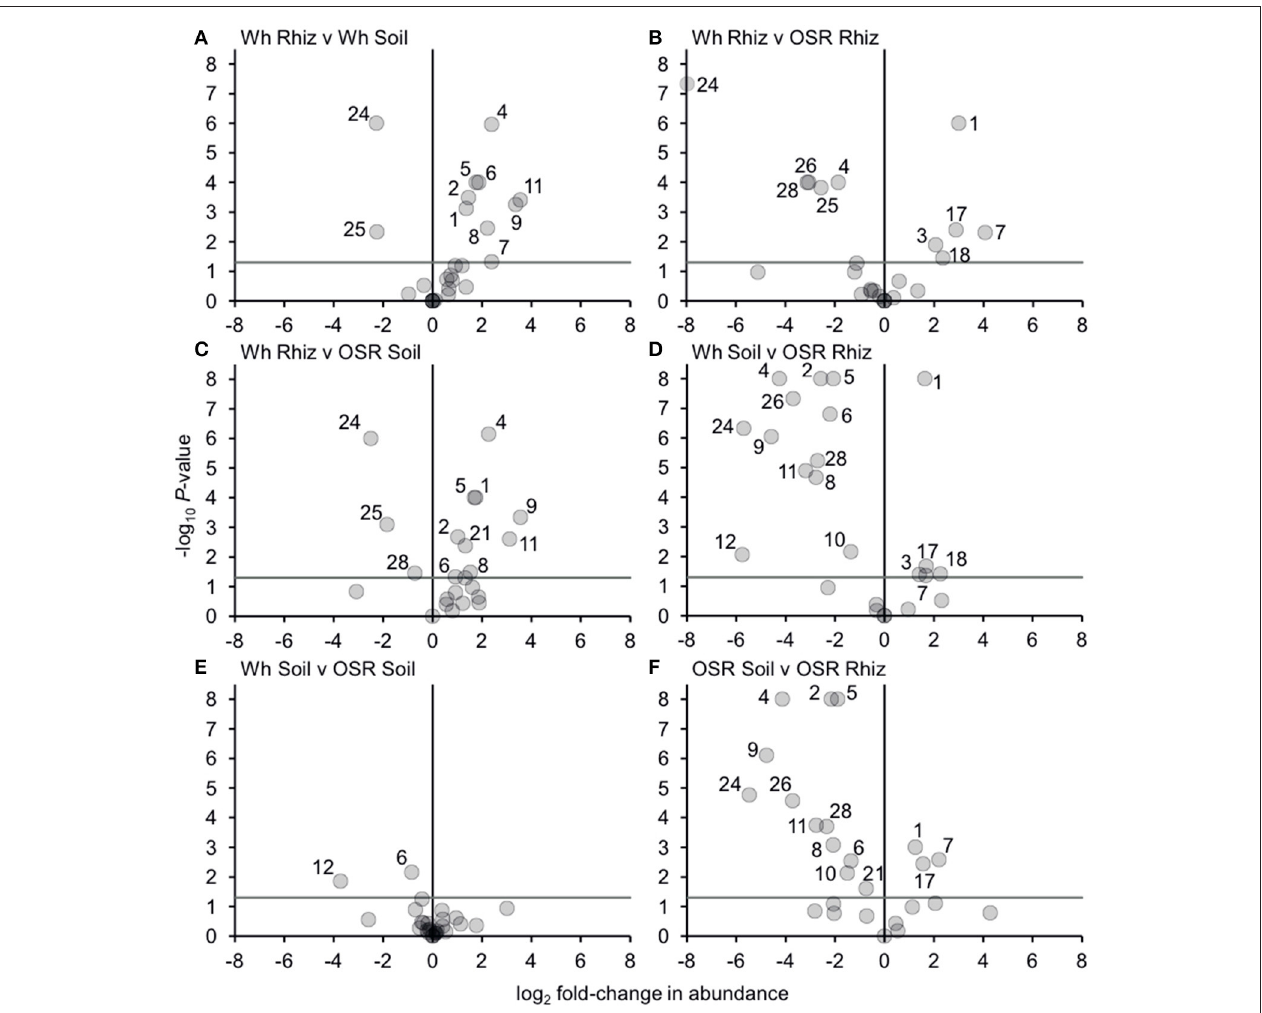
FIGURE 5 | Changes in plasmodiophorid OTU abundances between habitats. Visualized using volcano plots displaying fold-changes in relative abundance of OTUs between compared habitats. Positive and negative values represent increases and decreases in relative mean % OTU abundance within a habitat when compared to another habitat. The gray horizontal line depicts P = 0.05, with OTUs above that line having significant fold-changes in relative abundance, whereas those falling below the line are not significant. Numbers for OTUs with significant fold-changes in abundance are also